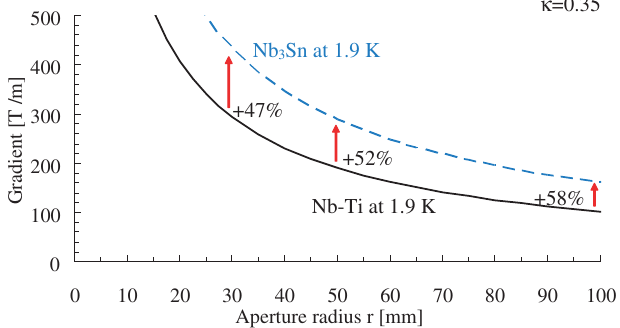
FIG. 27. (Color) Maximum critical gradient as a function of aperture radius for Nb-Ti and Nb of (24 (cid:9) ,30 (cid:9) ,36 (cid:9) ), (cid:3) (cid:2) 0 : 35